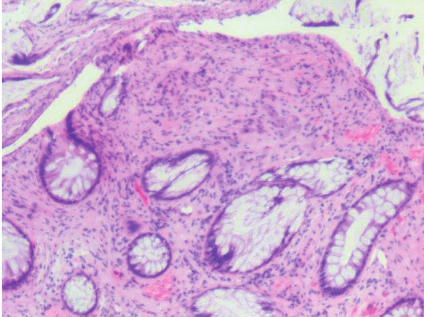
Figure 2: Hematoxylin and eosin stain of the colonic ganglioneu- roma. Ganglion and stromal cells are present in the lamina propria. Magnification: 4x.